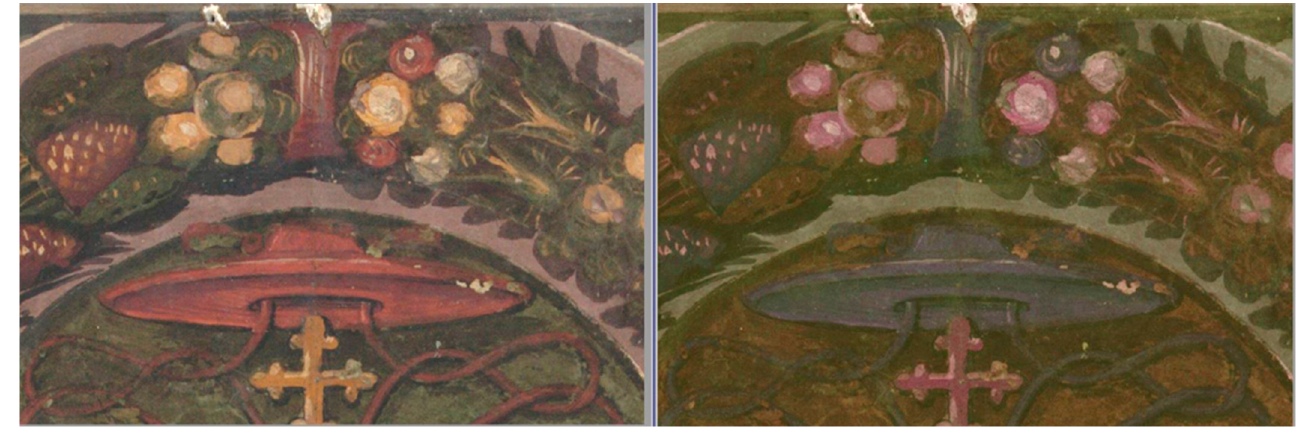
Figure 10. Detail of the frieze with the Cardinal’s hat. RGB image on the left and UVFC on the right, as obtained by PickViewer ® .